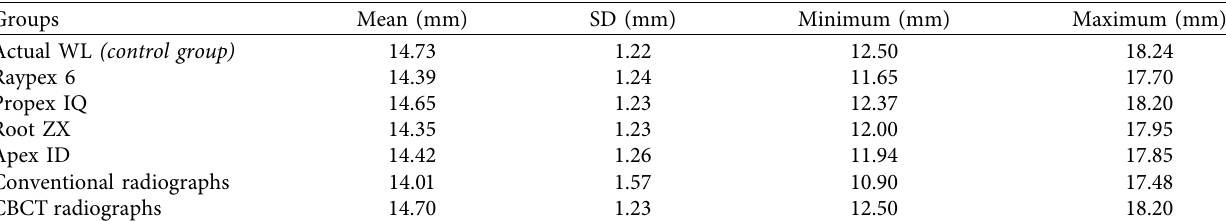
Conventional radiographs